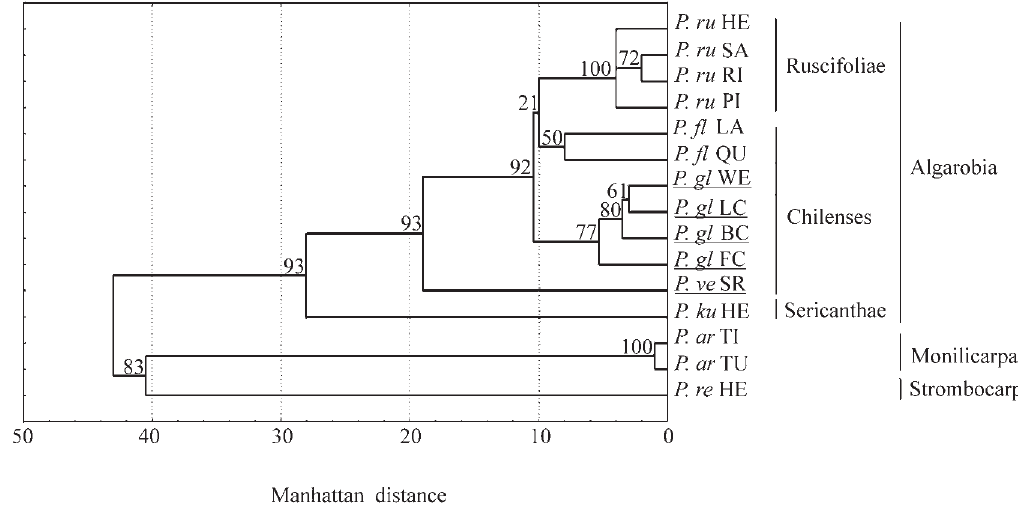
Figure 2 - Phenogram representative of Manhattan distances between populations of the species studied of genus Prosopis . Numbers over branches rep- resent bootstrap support for each node. North-American populations are